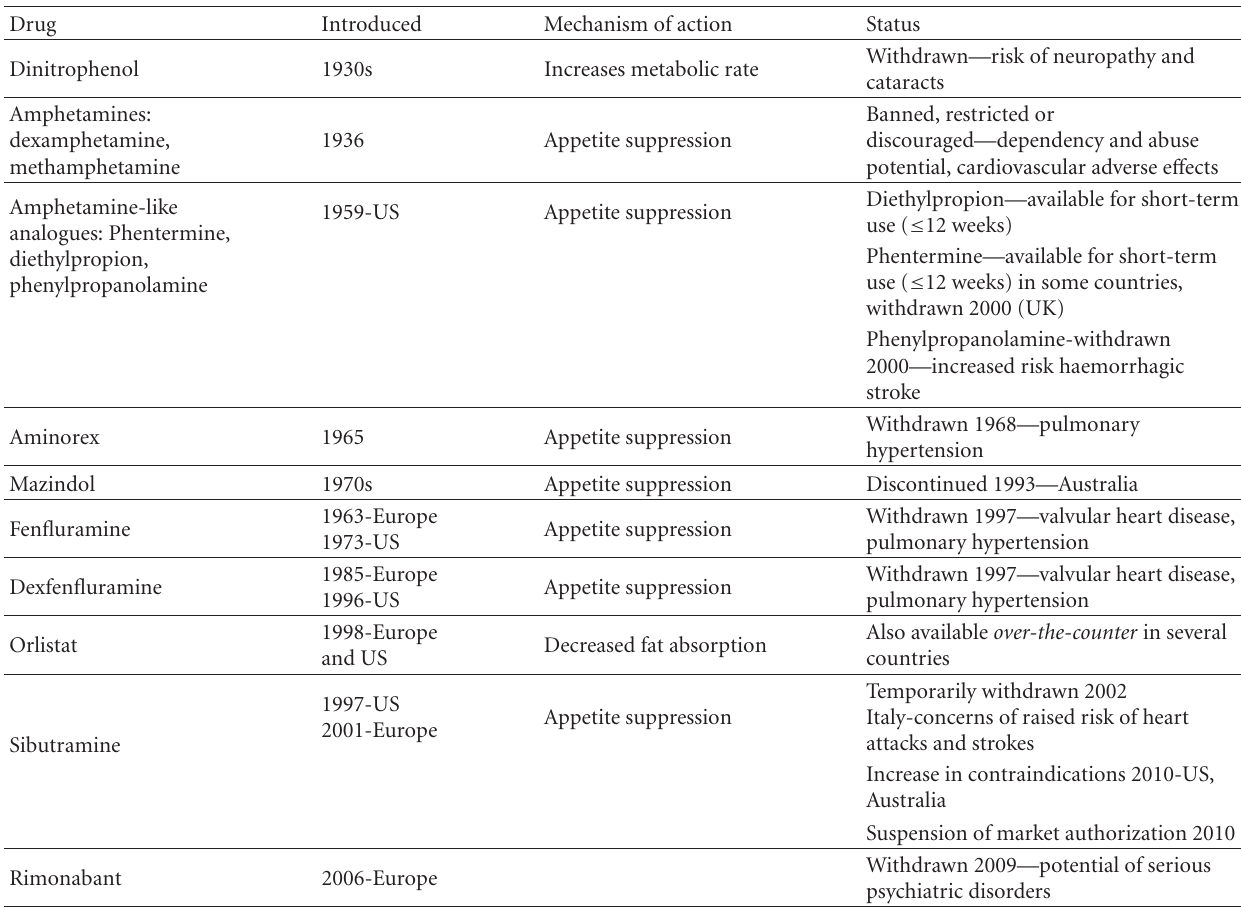
Table 1: Drugs used for weight loss in